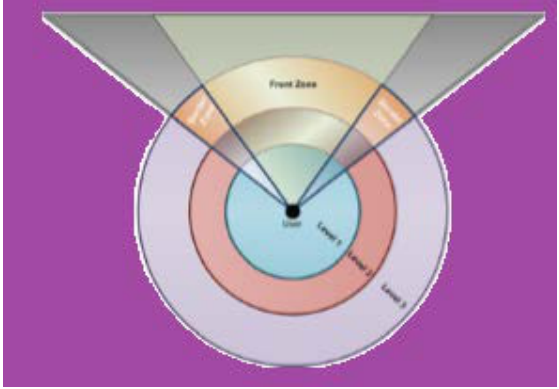
Figure 2: CityGML LoD with area of interest zoning The front headlight zoning is localized based on inverse pyramid polygon. The circular zoning localization is based on 3D sphere. LoD3.5 to LoD4 streaming should be focused on the front headlight zone. LoD 3 to LoD3.5 on the rear of front head light zone; the purple color zoning is classified for LoD1. For 3D sphere classification, the nearest sphere to user is LoD2.5 to LoD3, second sphere nearest to user is LoD2 to LoD2.5, while third sphere which is the furthest to user is LoD1 to LoD2 and the rest is